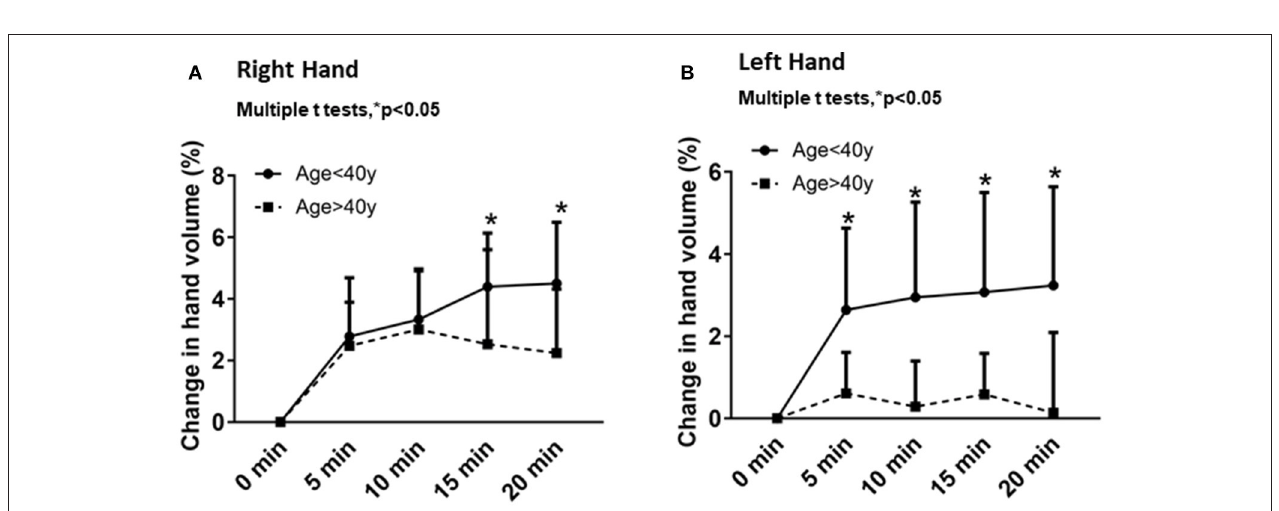
FIGURE 2 | Comparison of the hand volume changes from baseline in each age group for periods of 5, 10, 15, and 20min for the right hand (A) and the left hand (B). Values are means ± SD. * p < 0.05 by multiple t